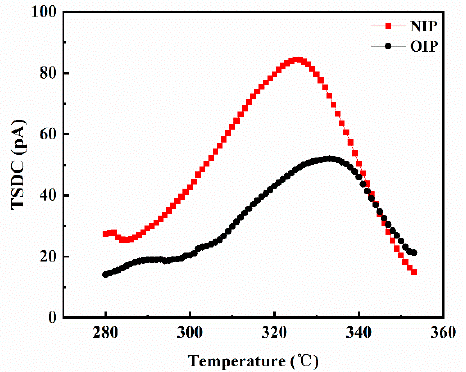
Figure 11. The test curves of TSDC for OIP and NIP.